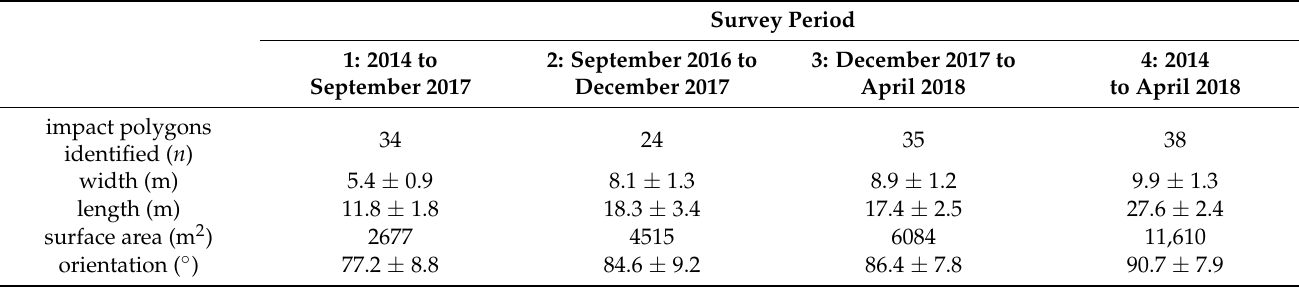
Table 6. Mean ± standard error for access impact polygon geometries during the survey periods, 2014 to April 2018. Orien- tation is reported in degrees from true north, and surface area as the summed surface area of the identified impact polygons.